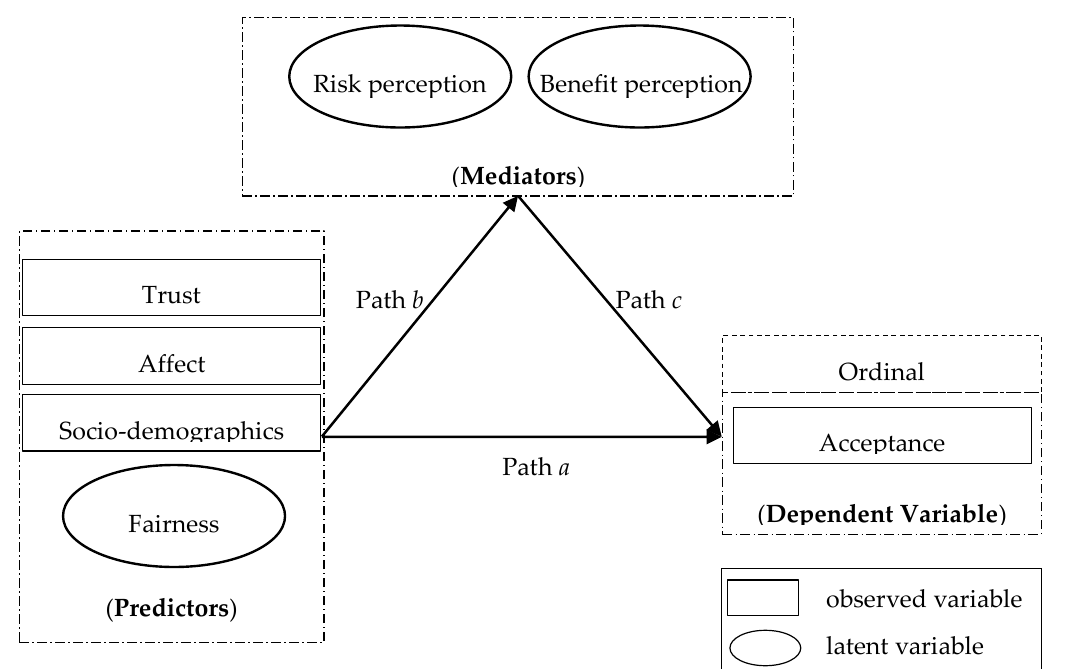
Figure 1. Conceptual model explaining local residents’ attitudes toward SGE.